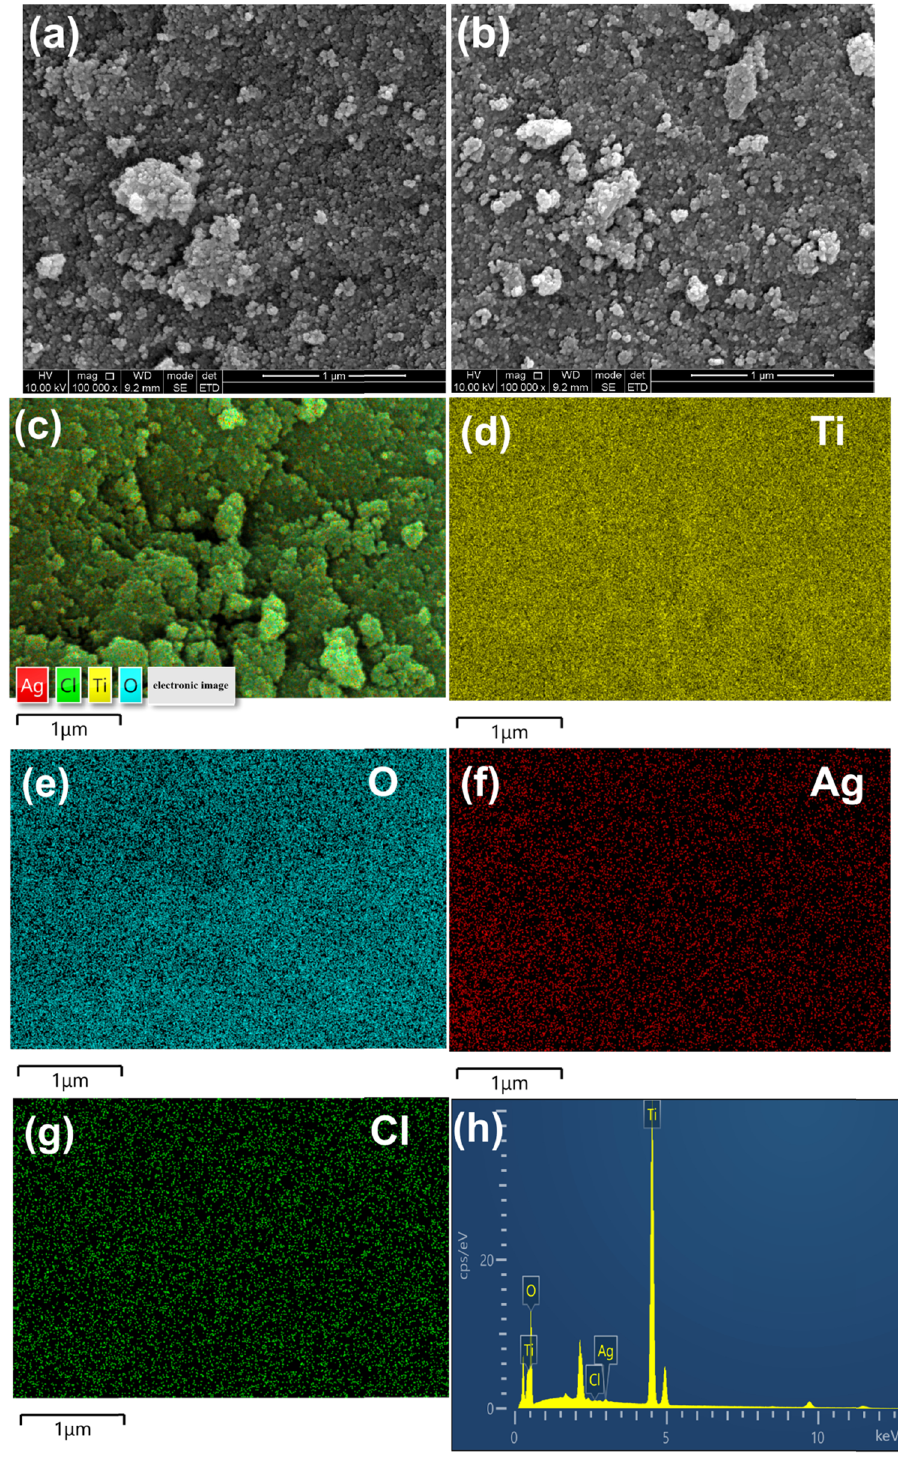
Figure 2: SEM images of ARB ( a ) , Ag@AgCl – ARB ( b ) , element mappings ( c – g ) , and EDS analysis of Ag@AgCl – ARB ( h )